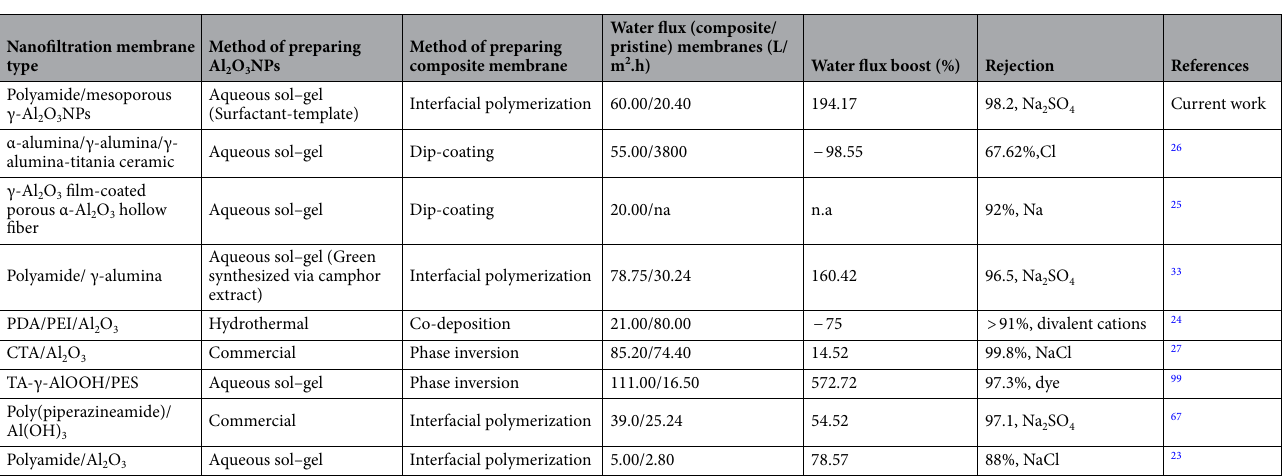
Table 3. Summary of previously published nanofiltration membranes composed of Al 2 O 3 -NPs. n.a. not